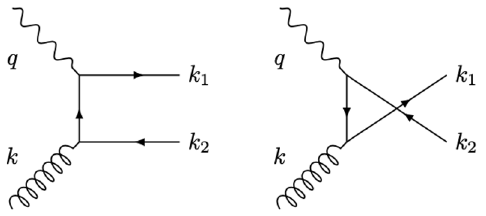
Figure 5 . The two Feynman diagrams contributing to the heavy-quark pair photoproduction cross